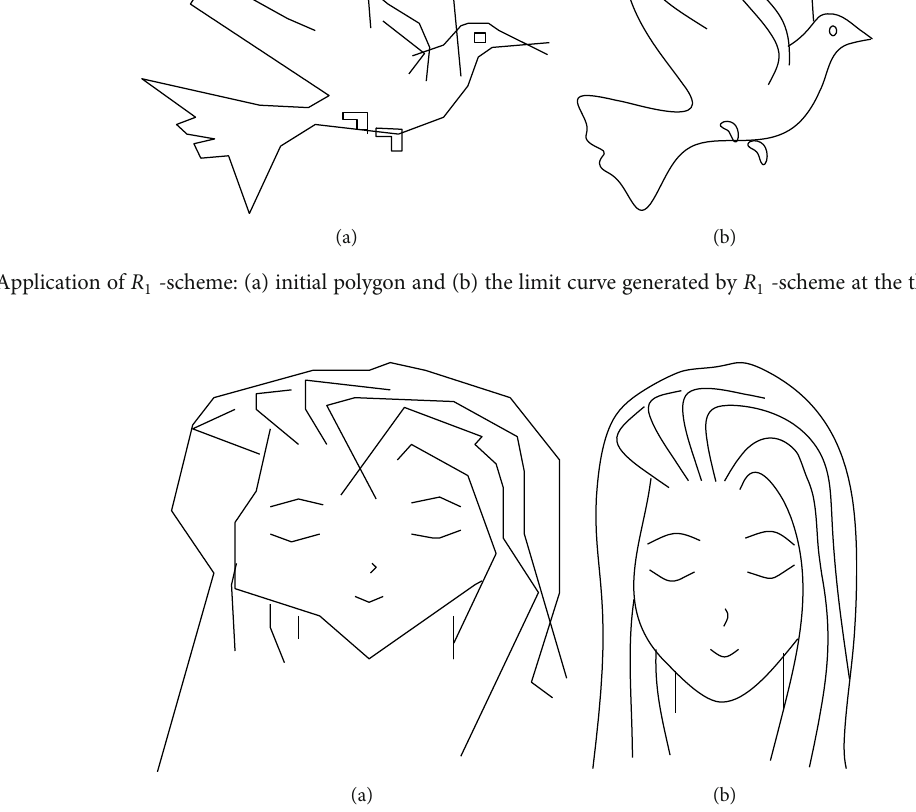
-scheme: (a) initial polygon and (b) the limit curve generated by R 2